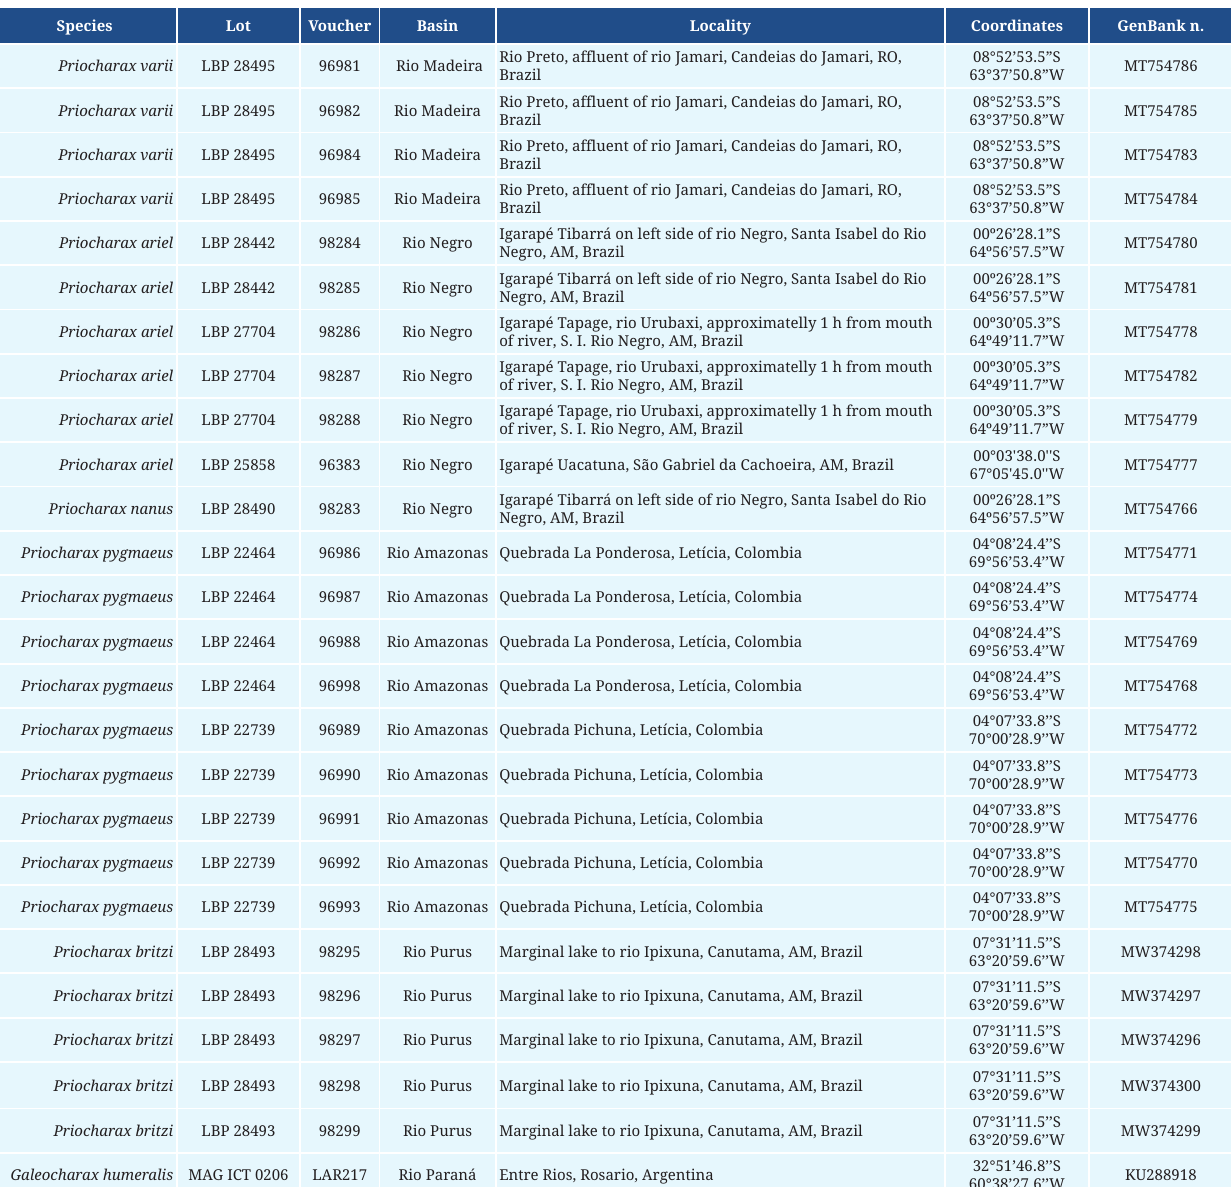
TABLE 1 | Species, lots, vouchers, basins, locality information, and GenBank accession numbers of samples used in this study. In the locality column, Brazilian states are abbreviated as follows: AM = Amazonas, RO = Roraima. Species Lot Voucher Basin Locality Coordinates GenBank